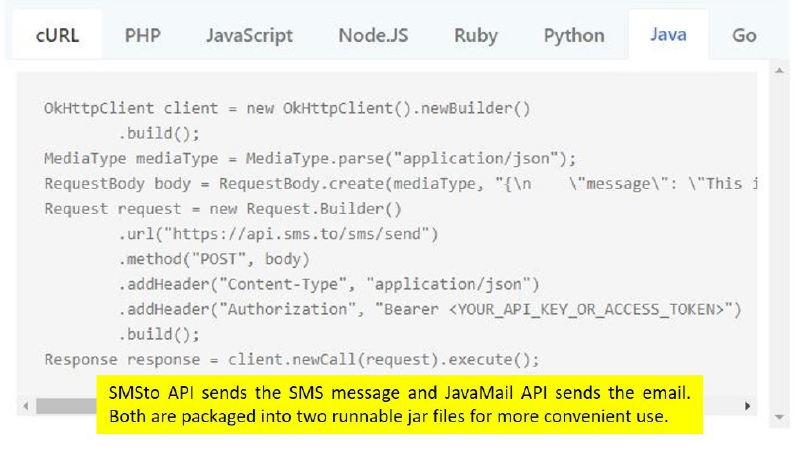
Figure 18. SMSto API interface.